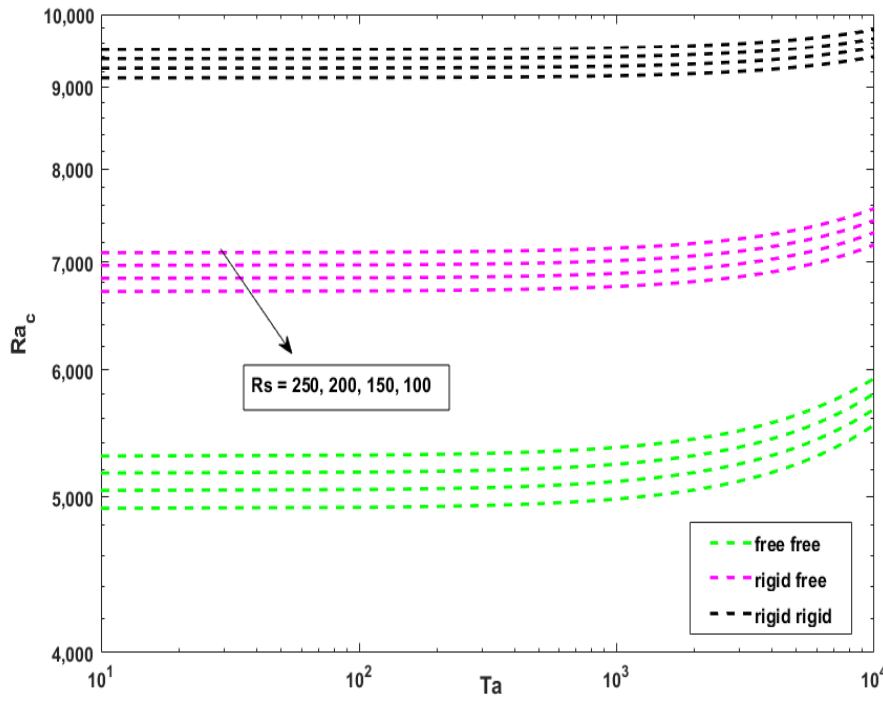
Figure 6. Variation of Ra c with Ta for Da = 0.01, Du = 0.02, Sr = 0.2, Le = 5, Λ = 8, M = 0.9, ϕ = 0.9.